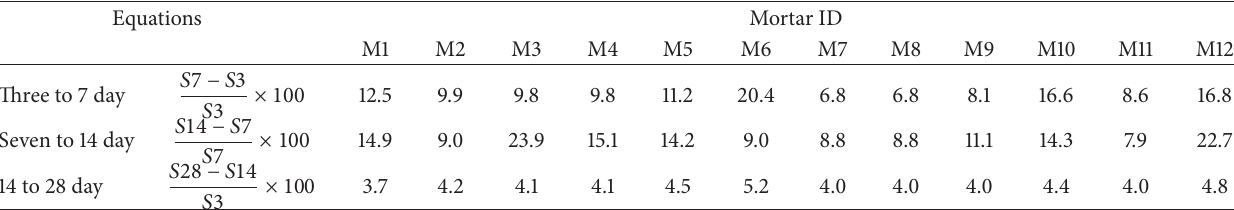
Table 6: Percentage of increment of compressive strength.